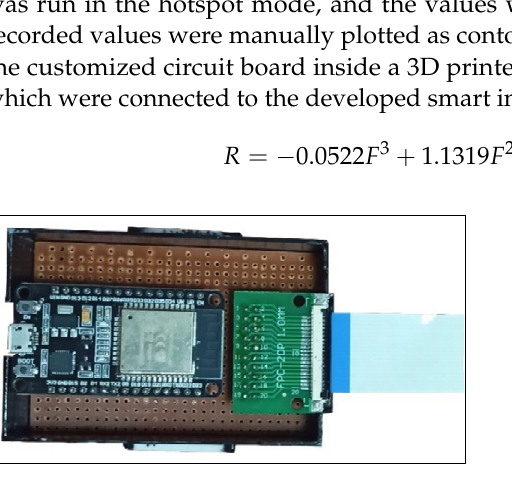
Figure 5. Circuit box along with the ESP-32, FFC connector, and FFC cable.